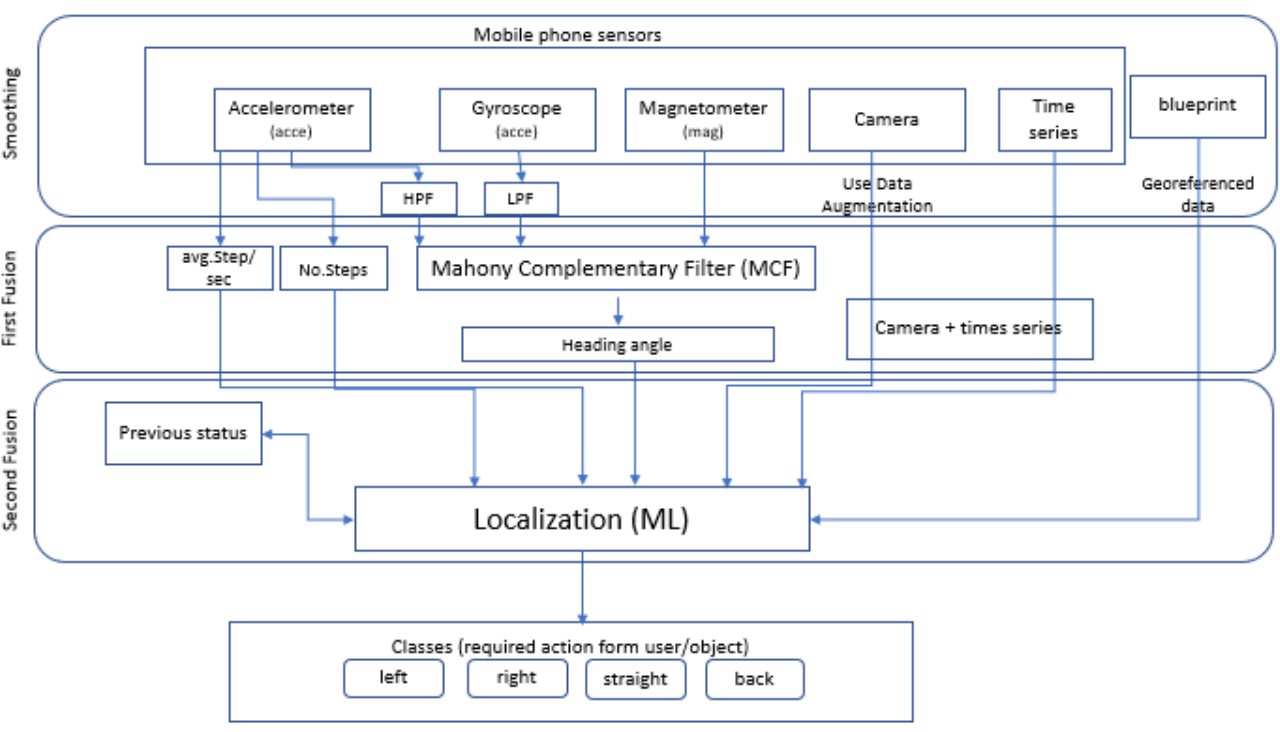
Figure 5. Framework of handheld-device-based indoor localization with zero infrastructure.